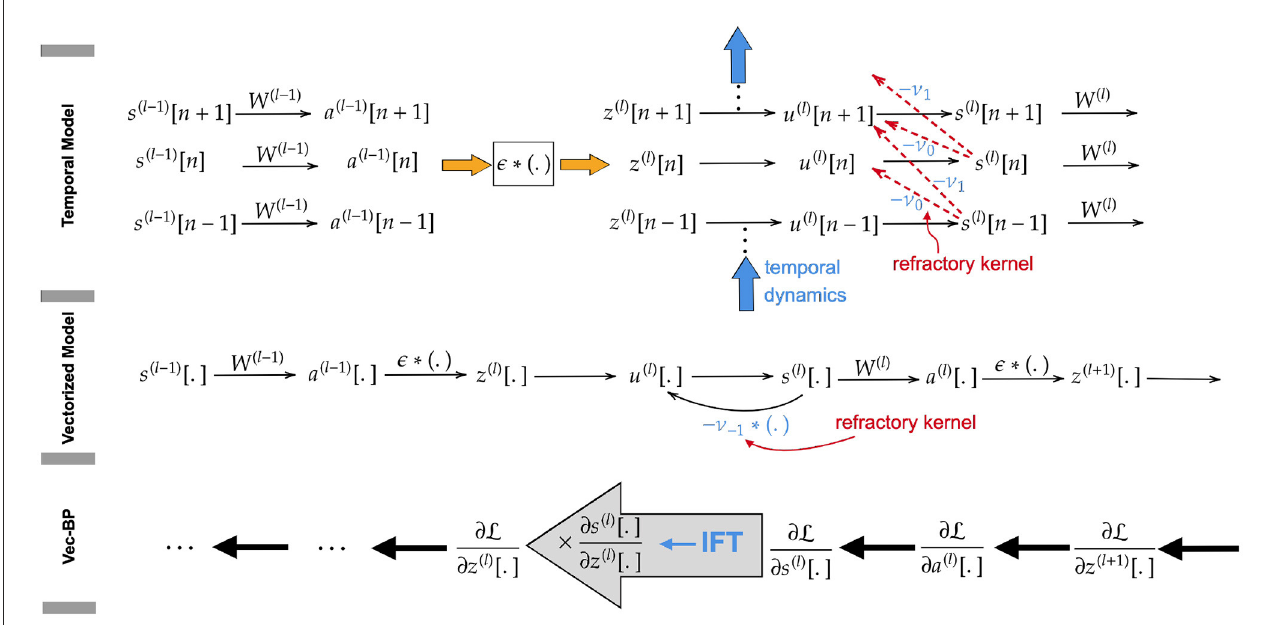
FIGURE1 (Upper) Directed acyclic computation graph along temporal and spatial dimension. (Middle) Loopy computation graph after vectorization along the temporal dimension. The loop is introduced by the reset kernel and is ignored in the backward path of SLAYER. (Lower) Vectorized backward path, applying IFT to back-propagate the gradients through the loopy computation